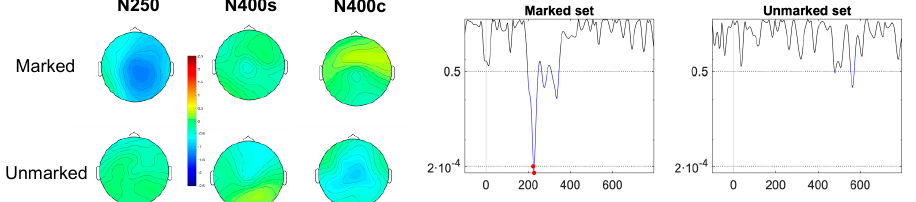
Figure 2. ERP results in Experiment 2: highly proficient Spanish–English bilinguals. ( A ) ERPs associated with the switch (thick lines) and non-switch conditions (thin lines) in the marked (upper) and unmarked (lower) sets. Time-windows of interest are marked in gray. ( B ) Topographical distribution of the language switch effects for marked and unmarked priming conditions in terms of amplitude differences between the unrelated Basque and unrelated Spanish primes. ( C ) Distribution of p -values for the language switch effect in marked and unmarked sets. The p -values are calculated from individual t -tests for every data point (every 4 ms, 225 comparisons in total) and collapsed across all electrodes. Blue lines indicate p -values <0.05. Red lines indicate p -values <0.0002 (Bonferroni corrected significance level; α = 0.05/255; p = 0.0002).